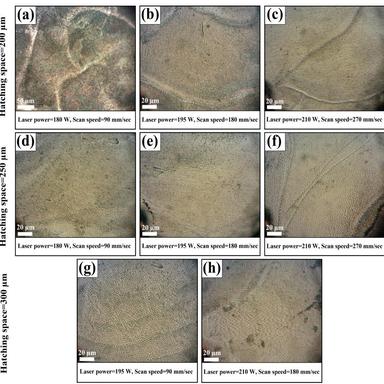
The grain structure of LPBF printed nanocomposite materials from the top cube surface by variation of hatching space at three different levels of (a-c) 200, (df) 250, and (g, h) 300 µm by changing the laser power and scanning speed within the ranges of 180–210 W and 90–270 mm/sec, respectively, for a constant thickness of feeding powder of ~ 20 µm.